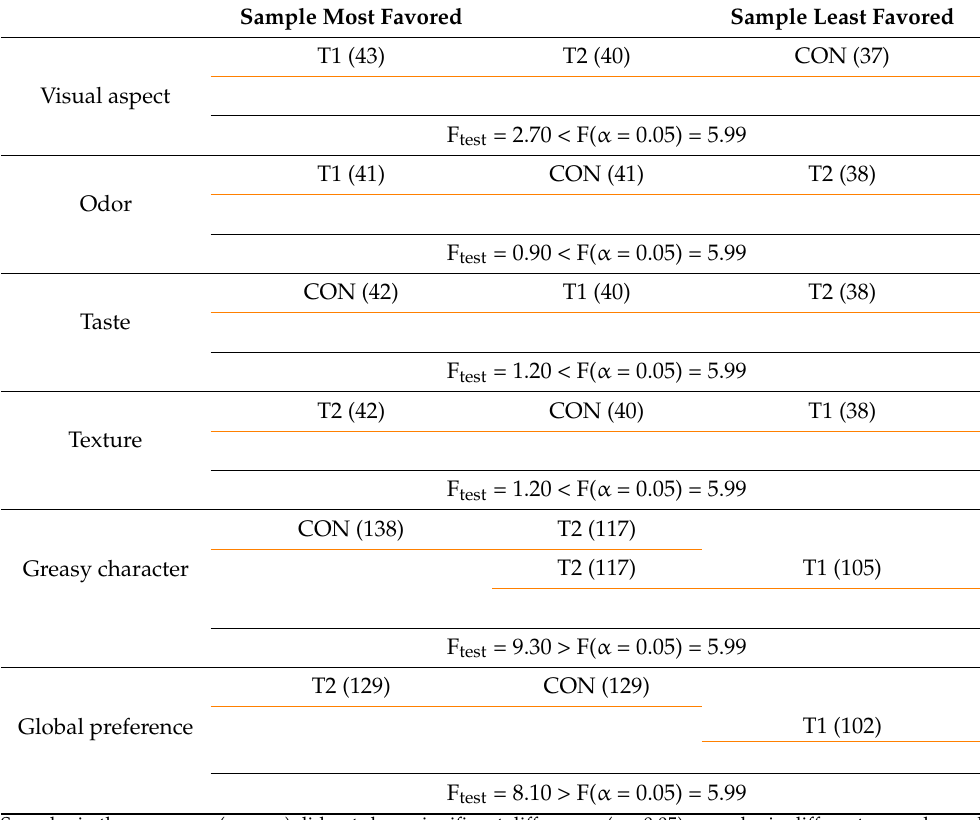
Table 6. Preference test results for the foal p â t é